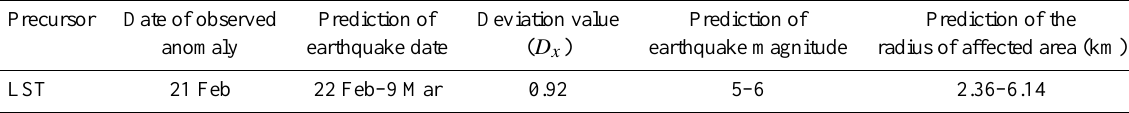
Table 8. Different precursors concerning the Zarand earthquake (Akhoondzadeh, 2011).